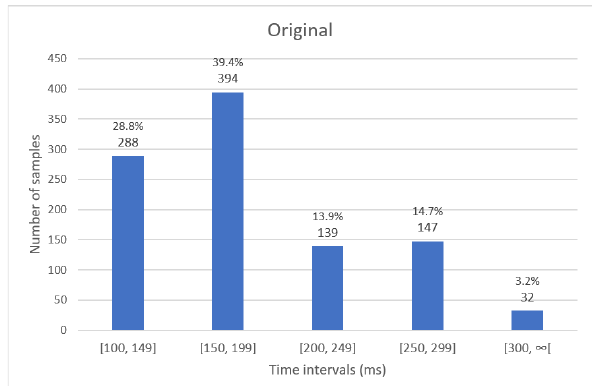
Figure 6. Delay distribution for the test performed with the original smart home network.